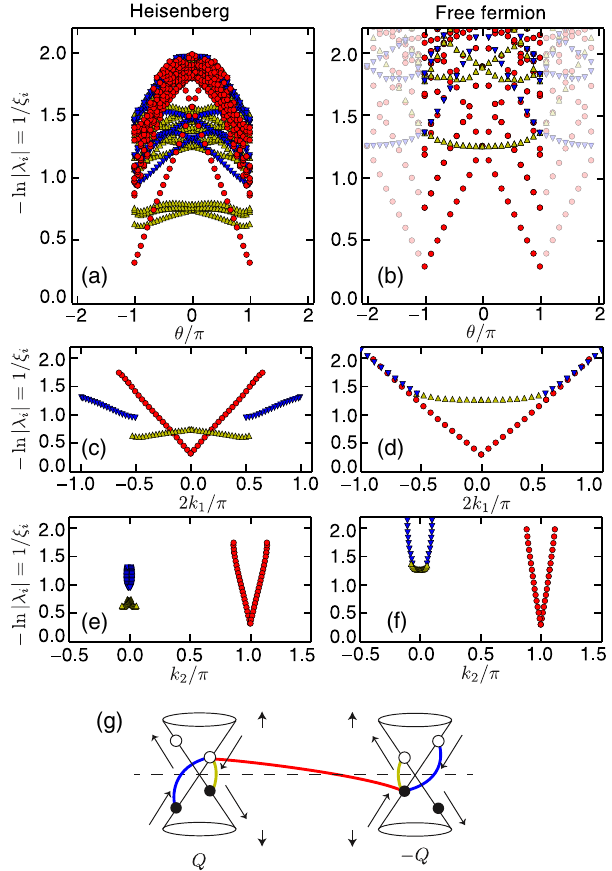
FIG. 4. The transfer matrix spectrum in the S z ¼ 1 sector (roughly the triplet channel) for the kagome Heisenberg model (a,c,e) and free-fermion model (b,d,f). The vertical axis is the inverse of correlation length 1 = ξ , which can be considered as the gap Δ of the excitations, up to a prefactor Δ ¼ v s = ξ . The horizontal axis denotes (a,b) the twist angle θ ; (c,d) momentum 2 k k – (f), we plot only the 1 ; and (e,f) momentum 2 . In panels (c) lowest level of each excitation type, cf. panel (g). The cylinder we show here is the YC8-2 cylinder for both cases, and the truncation error of DMRG is around 2 × 10 − 6 , which corresponds to bond dimension m ¼ 6000 for the kagome Heisenberg model and m ¼ 250 for the free-fermion model. For the kagome Heisenberg model, we also include a small J 2 ¼ 0 . 05 . The finite “ gap ” at the Dirac point appears to be due to the truncation error of DMRG simulations (see Fig. 15 in Appendix B 2e). (g) Three different types of particle-hole excitations. The arrows represent the direction of the movement of the discretized momentum under the twist boundary